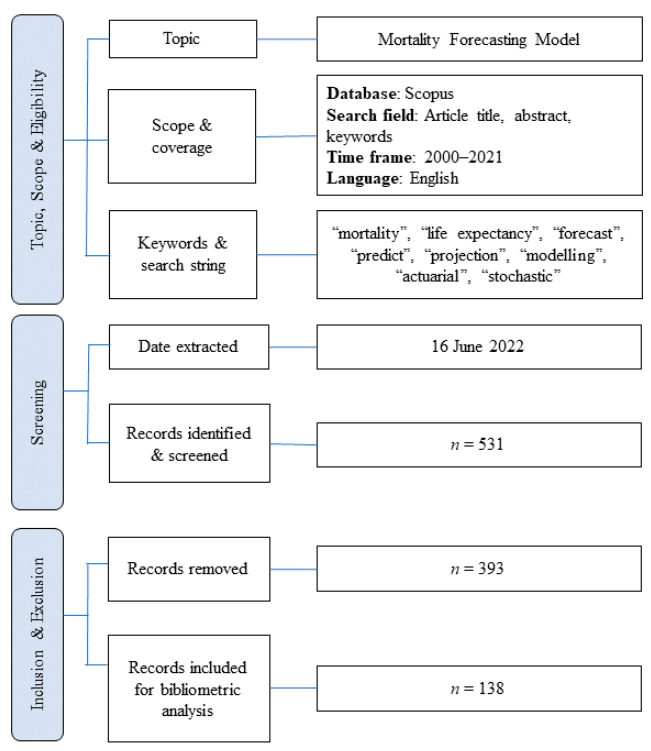
Figure 1. Flowchart of the research process.